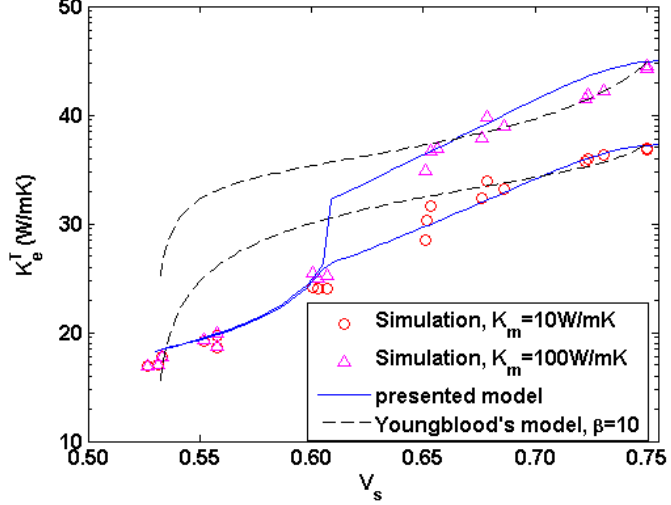
Figure 7. Comparison of the calculated transverse thermal conductivity of four-phase system and the predicted values by the presented and Youngblood’s expressions for K T i = 40 W · m − 1 · K − 1 , K m = 10 and 100 W · m − 1 · K − 1 , K p = 0.01 W · m − 1 · K − 1 , V f = 0.5 and V i = 0.05.